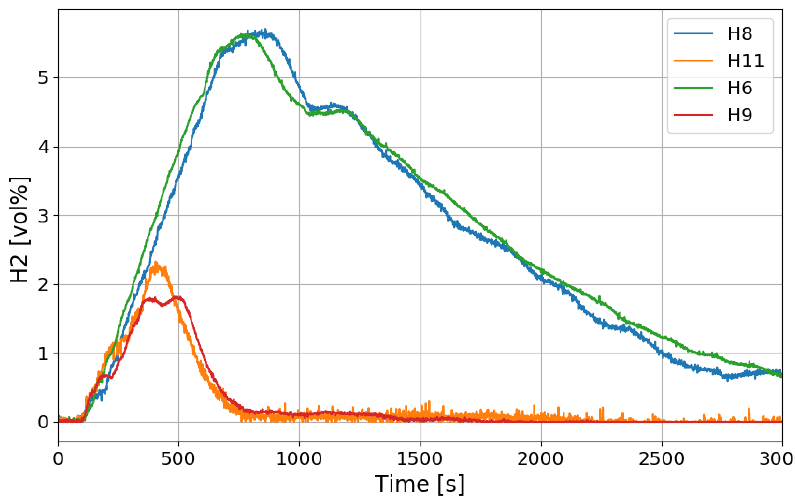
Figure 13. Hydrogen concentrations at inlets and outlets of the PARs for the SP1 test, H6, H9: inlet and outlet of the left PAR, H8, H11: inlet and outlet of the right PAR.